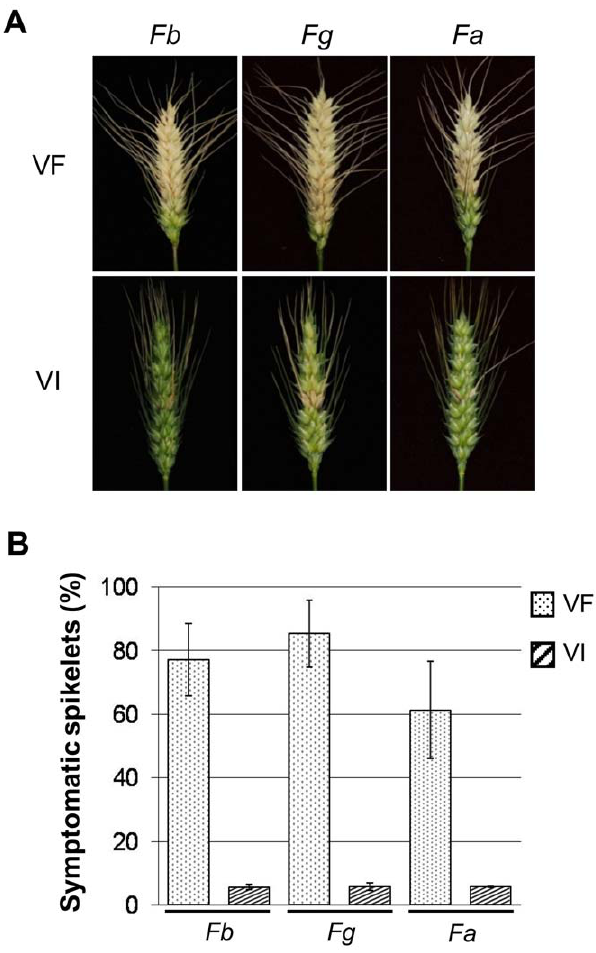
Figure 5. Disease symptoms in wheat head spikelets inoculated with fungal strains belonging to the Fusarium graminearum species complex. Conidial suspensions of each strain either un- infected or infected with FgV1-DK21 were used to inoculate wheat plants. Error bars indicate standard deviation.